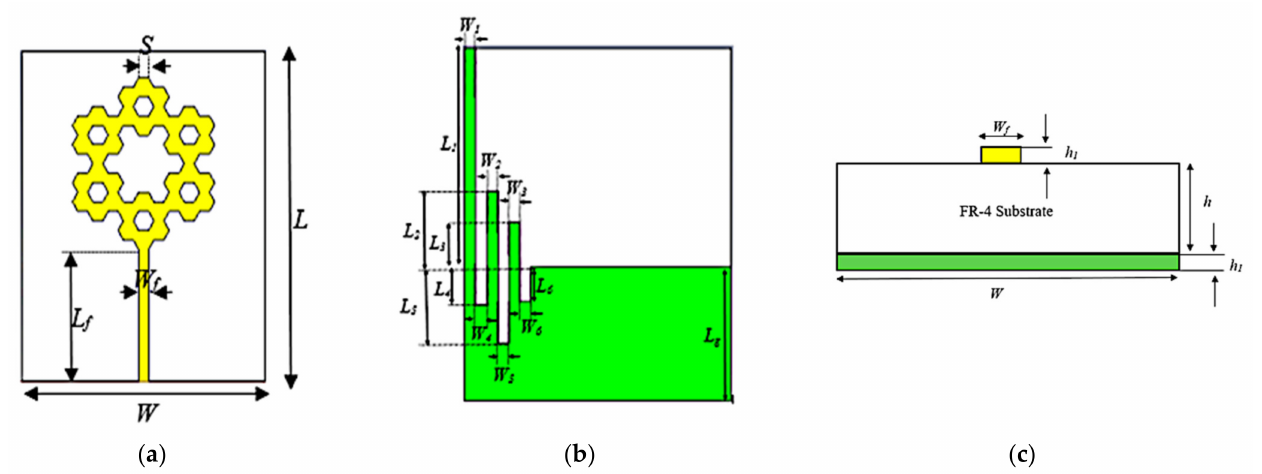
Figure 1. Geometry of Sierpinski hexagonal-shaped fractal antenna: ( a ) top view; ( b ) back view; and ( c ) side view.